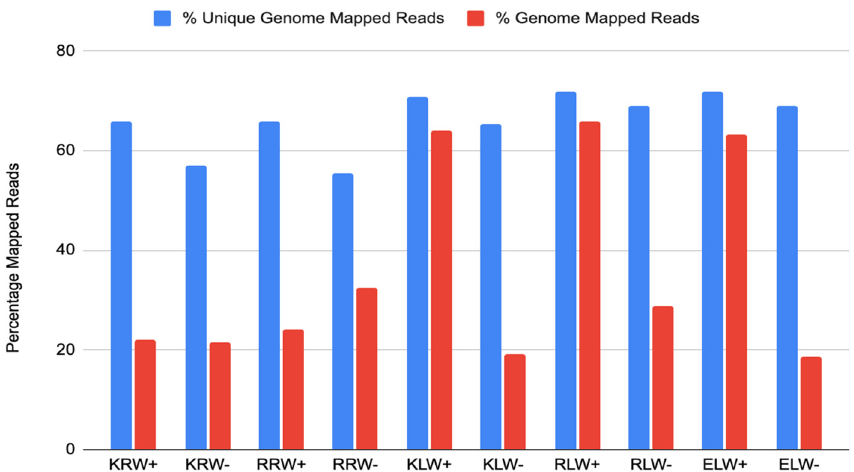
Figure 1. Percentage of genome-mapped reads among the 10